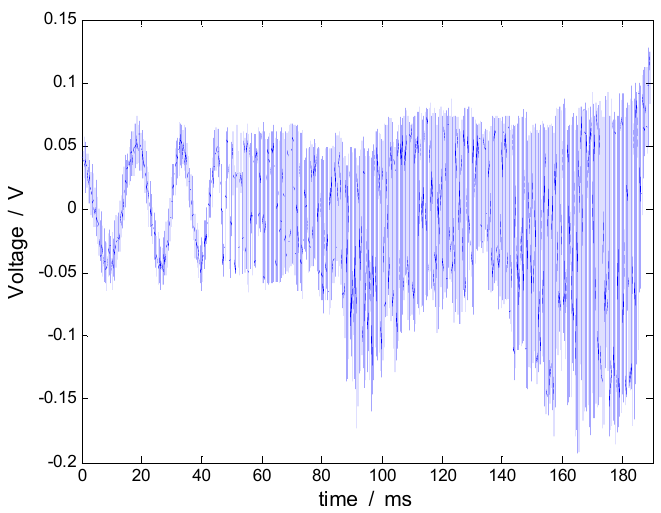
Figure 11. Doppler signal from the interferometer.